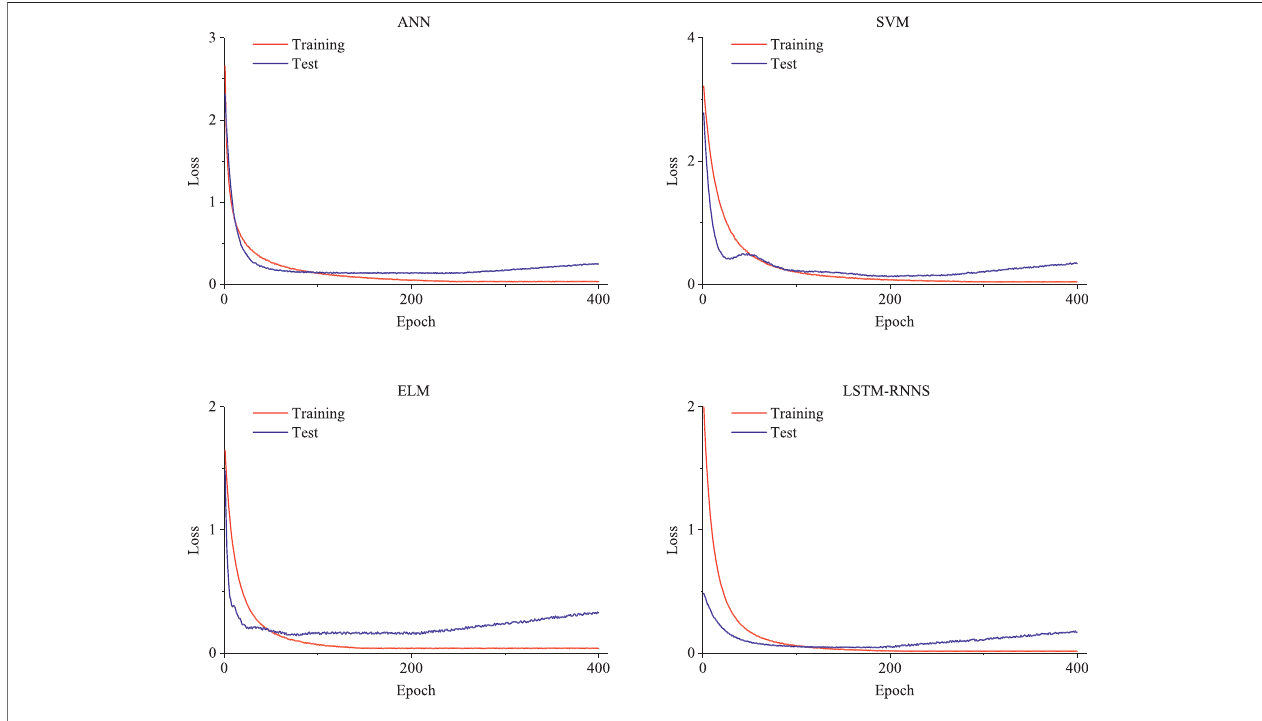
FIGURE 6 | Calculation results of four algorithm loss curves.